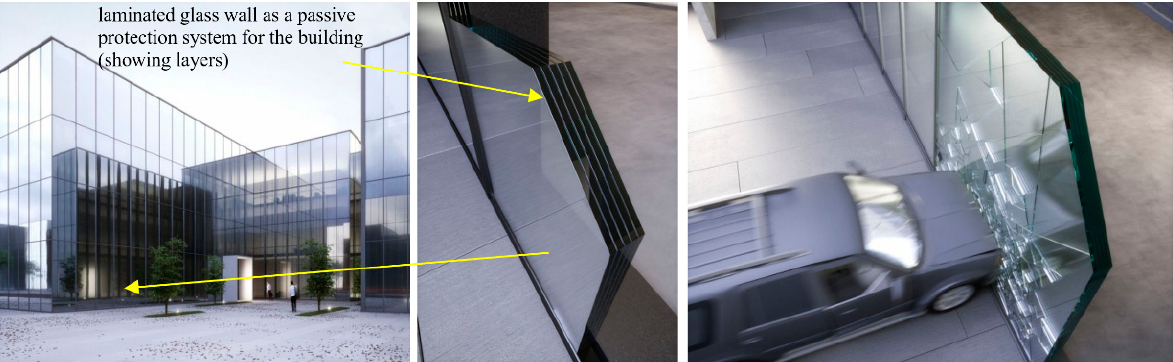
Figure 4. An example of a possible deployment of a laminated glass wall as a passive protection system with a fully glazed facade.